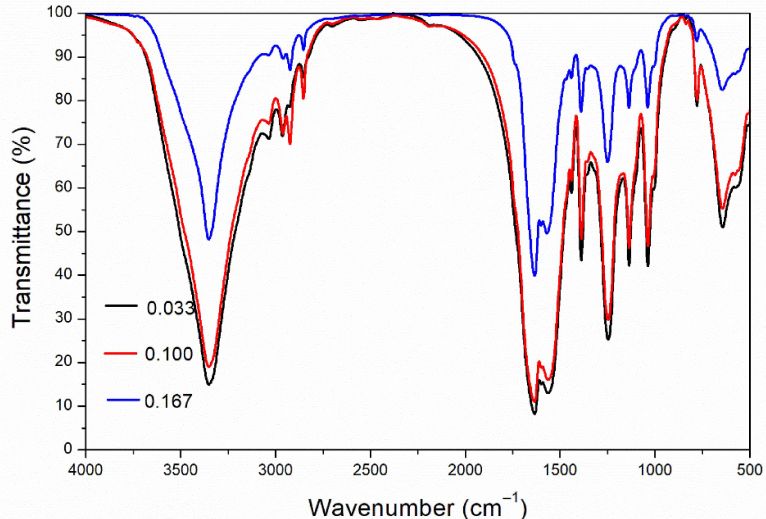
Figure 3. Infrared spectroscopy of microcapsules with different core–to–wall ratios.